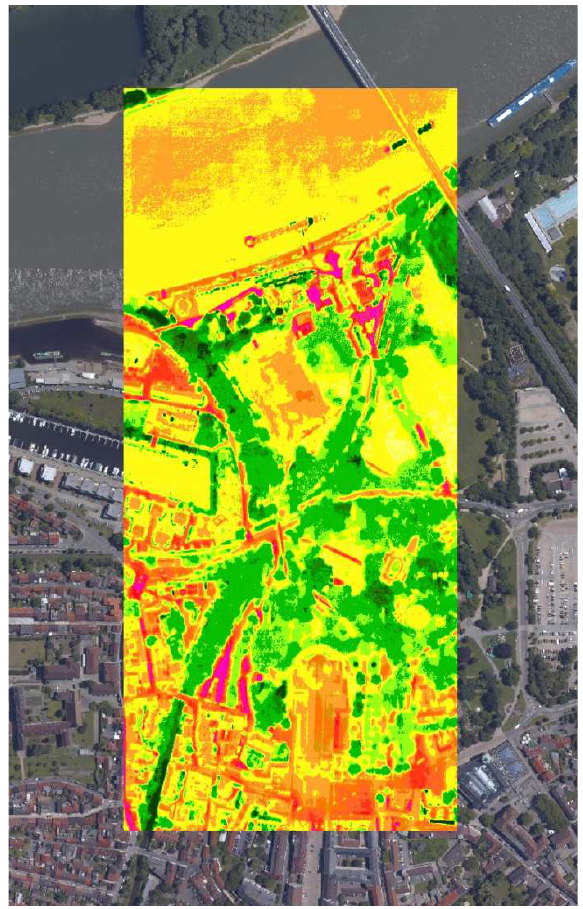
Figure 7: Thermal im age overlaid over an Orthophoto of a age overlaid over an Orthophoto of a daytime survey for monitoring city climate. Green areas close to daytime survey for monitoring city climate. Green areas close to water bodies reduce the temperature by transpiration. water bodies reduce the temperature by